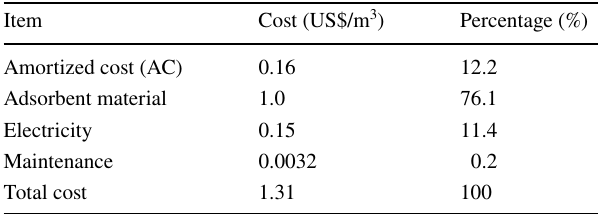
Table 4 Cost estimation of scaling up the adsorption unit for treating MB dye for an industry with a capacity of 100 m 3